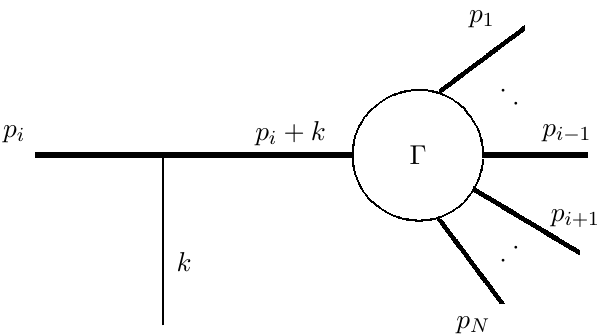
Figure 1 . Source of the leading contribution to the amplitude with one external soft graviton.